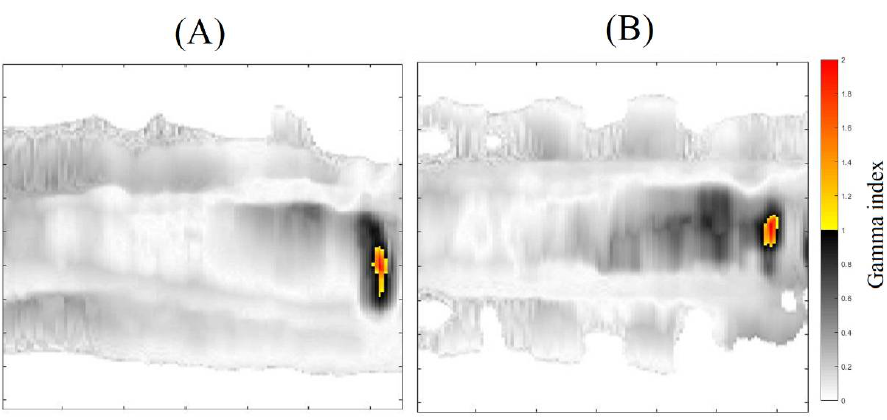
Figure 8. Gamma map images for the sagittal ( A ), and Coronal plans ( B )—Threshold of 40%.